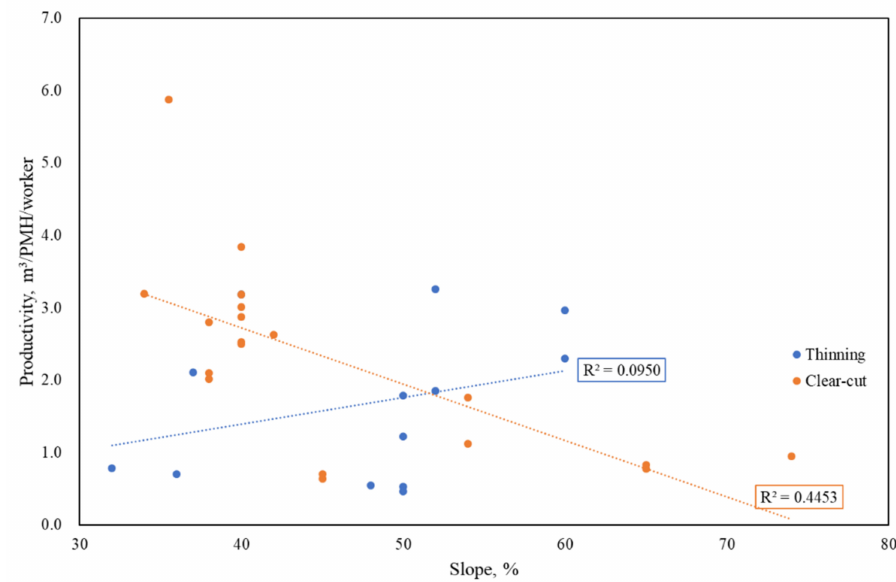
Figure 9. Productivity relationship with the slope. This rate had a weak-to-moderate correlation with slope in thinning operations, whereas it had a significant correlation in clear-cut operations.